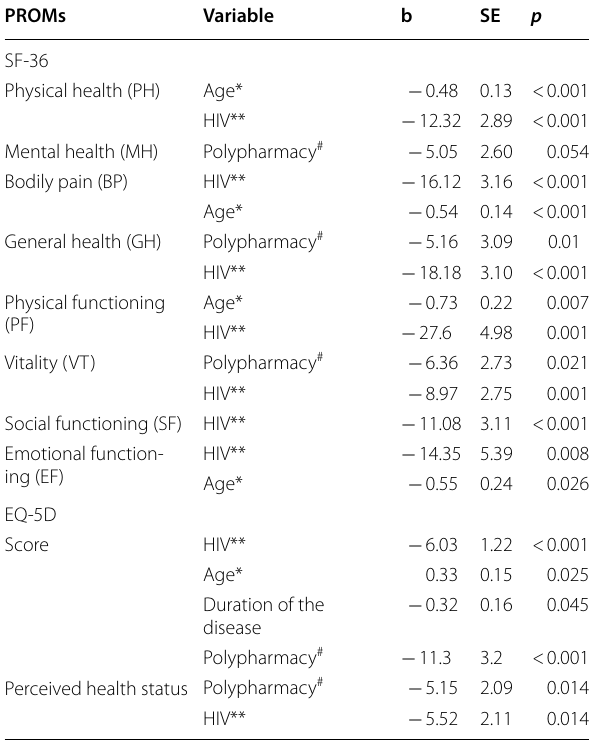
Table 4 Significative ( p < 0.05) correlations between PROMs and socio-demographic and clinical characteristics at multiple regression